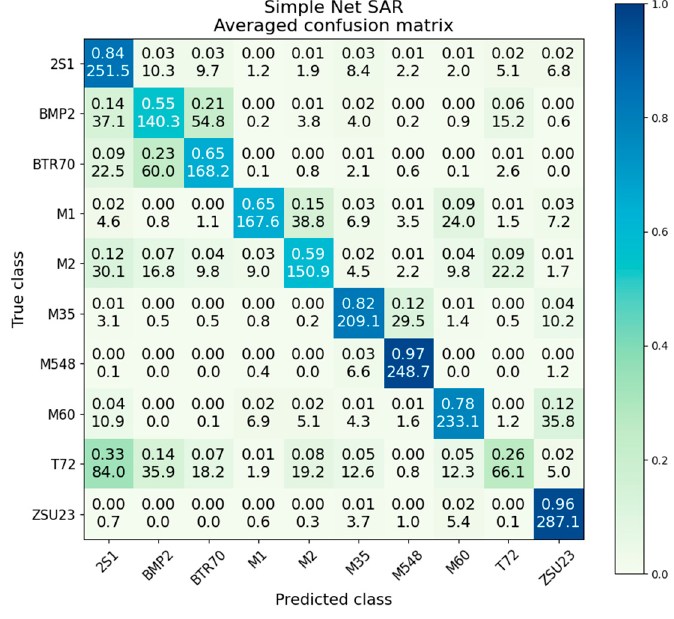
Figure 9. Averaged confusion matrix for simple net on SAR data.